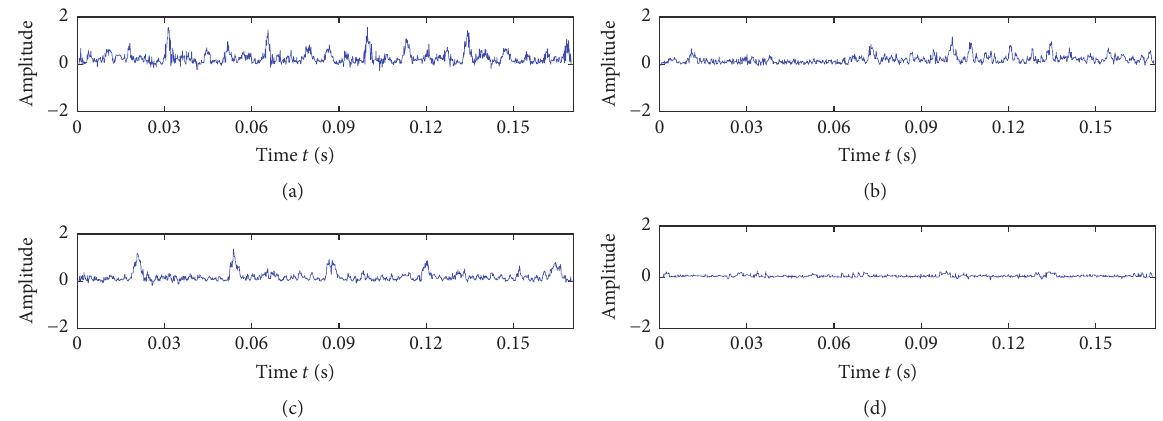
Figure 6: Processed signal via varying-scale morphological analysis: (a) inner race fault, (b) ball fault, (c) outer race fault, and (d) healthy state.